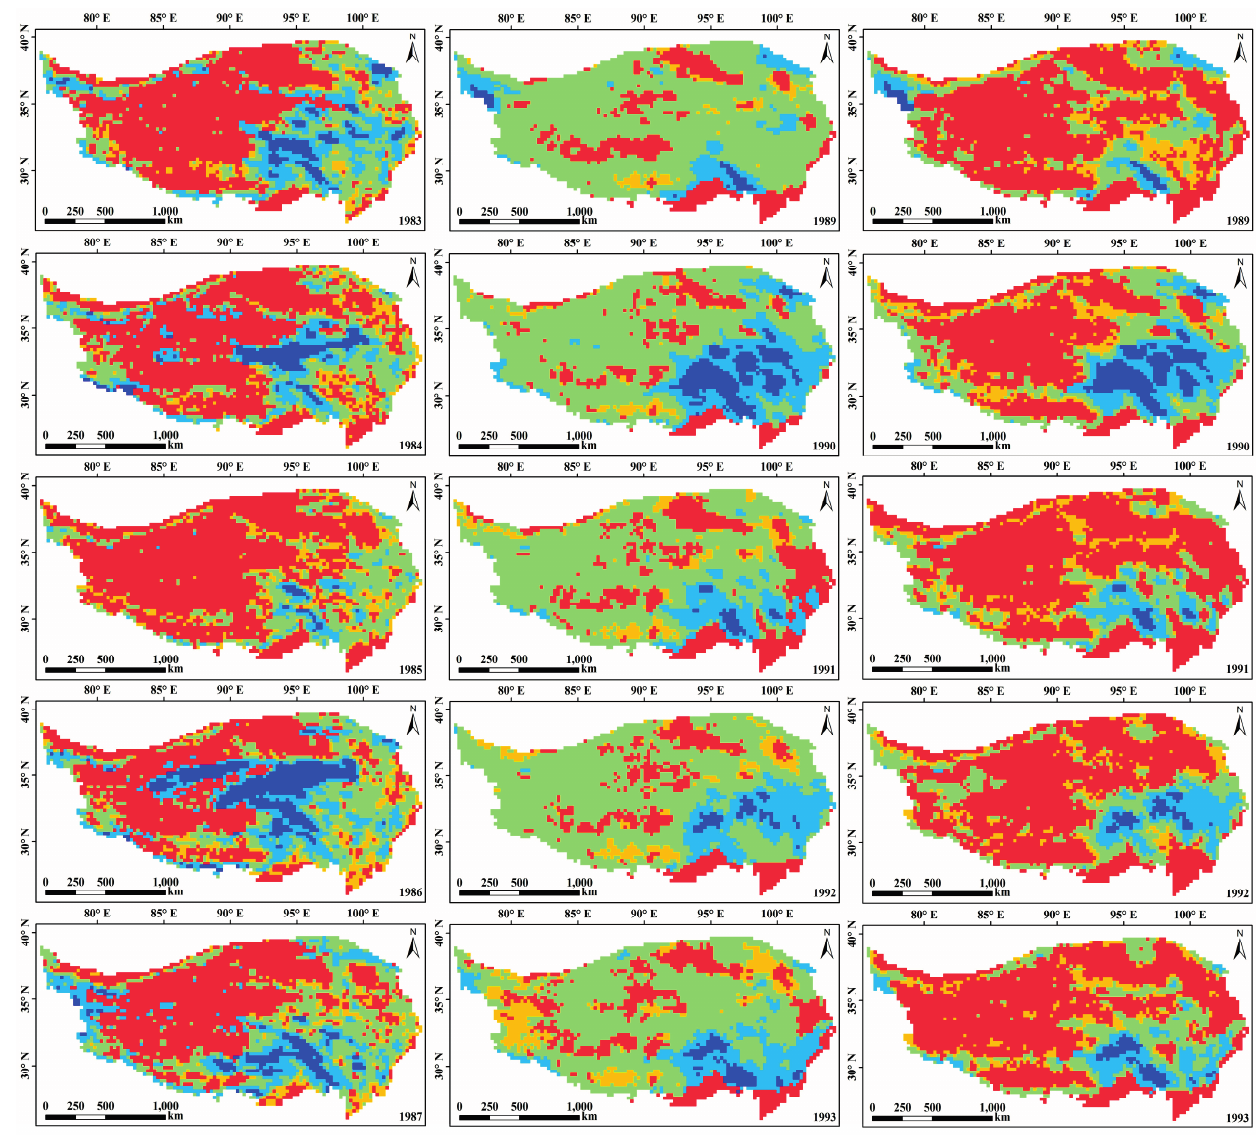
Figure 5. Comparison of snow depths derived from the SMMR (1983–1987) and SSM/I before and after the calibration (1989–1993); ( left ) snow depth distribution from the SMMR; ( middle ) snow depth distribution from the SSM/I; and ( right ) snow depth distribution from the calibrated